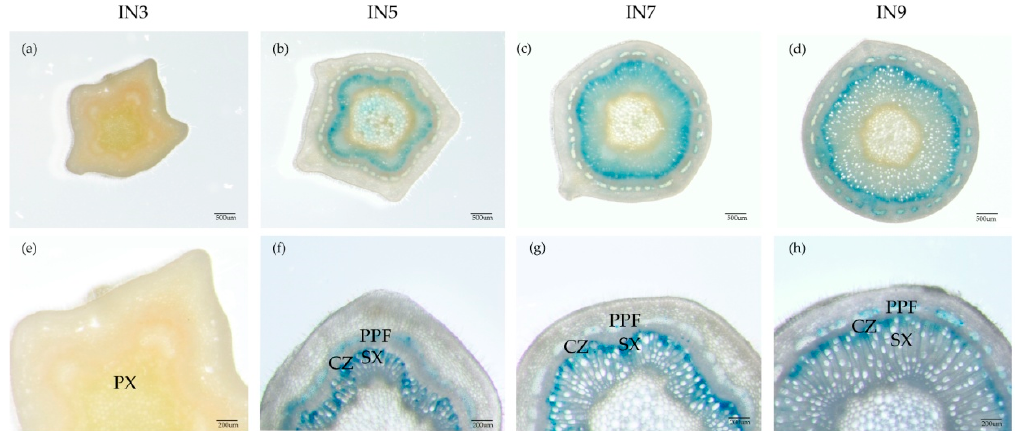
Figure 7. Histochemical GUS assay in the developing stems of PtrRHH94pro::GUS transgenic young trees. ( a – d ) Cross-sections of the internodes (INs) 3, 5, 7 and 9; ( e – h ) the magnified cross-sections of the INs 3, 5, 7 and 9. PX, primary xylem; PPF, primary phloem fiber; CZ, cambial zone; SX, secondary xylem.